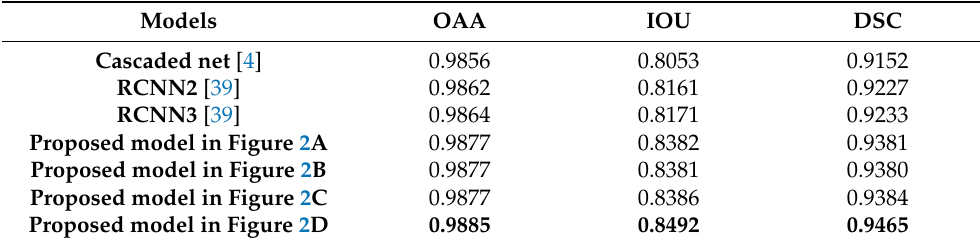
Table 2. Evaluation metrics of the models for road extraction. The results are the average of the performance for all epochs of all images in the test set. The bolded values are the highest. OAA, overall accuracy; IOU, an intersection over union; DSC, dice